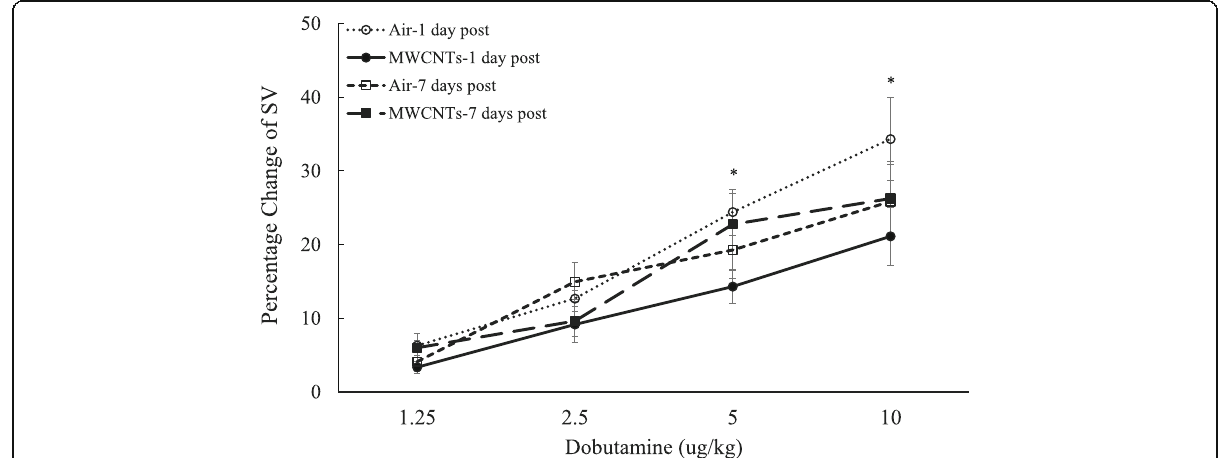
Fig. 3 Line graph depicting a percentage change of stroke volume (SV) from the basal level before exposure (pre-exposure control vs MWCNTs at 1 day post: 109.3 ± 7.0 vs 106.7 ± 10.4 μ l, control vs MWCNTs at 7 days post: 118.8 ± 5.7 vs 127.5 ± 3.7 μ l). Each value represents the mean ± SE of eight rats. P < 0.01 exposed compared with control group at 1 day post-exposure (*)